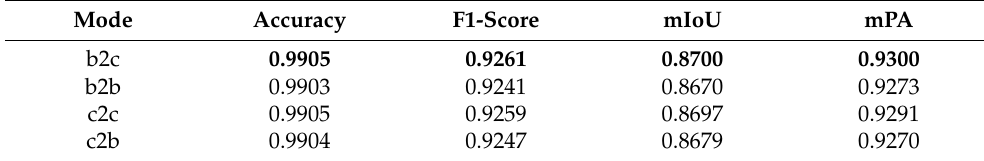
Table 5. Results of different connection mode.